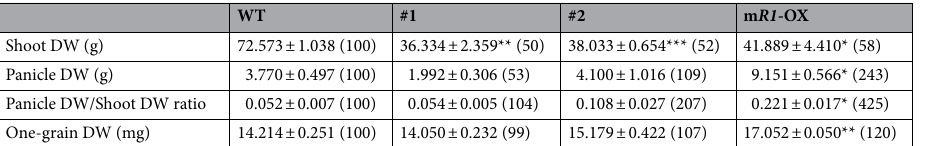
Table 3. Characterization of shoots, panicles, and grains of mature WT, R1 -Cas #1 and #2, and m RDD1 -OX plants (m R1 -OX) at the mature stage under high-temperature conditions. Data are represented as the average ± standard error of the mean ( n = 3). Asterisks indicate significant differences relative to the WT plants based on the Student’s t -test (* P < 0.05, ** P < 0.01 and *** P < 0.001). Values relative to those of WT as 100 are shown in parentheses. DW, dry